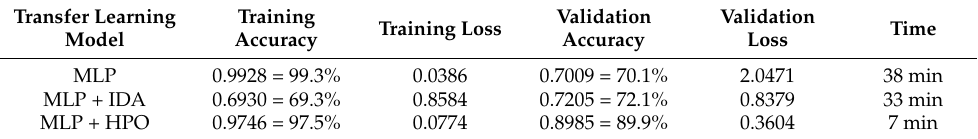
Table 9. Summary of MLP results.